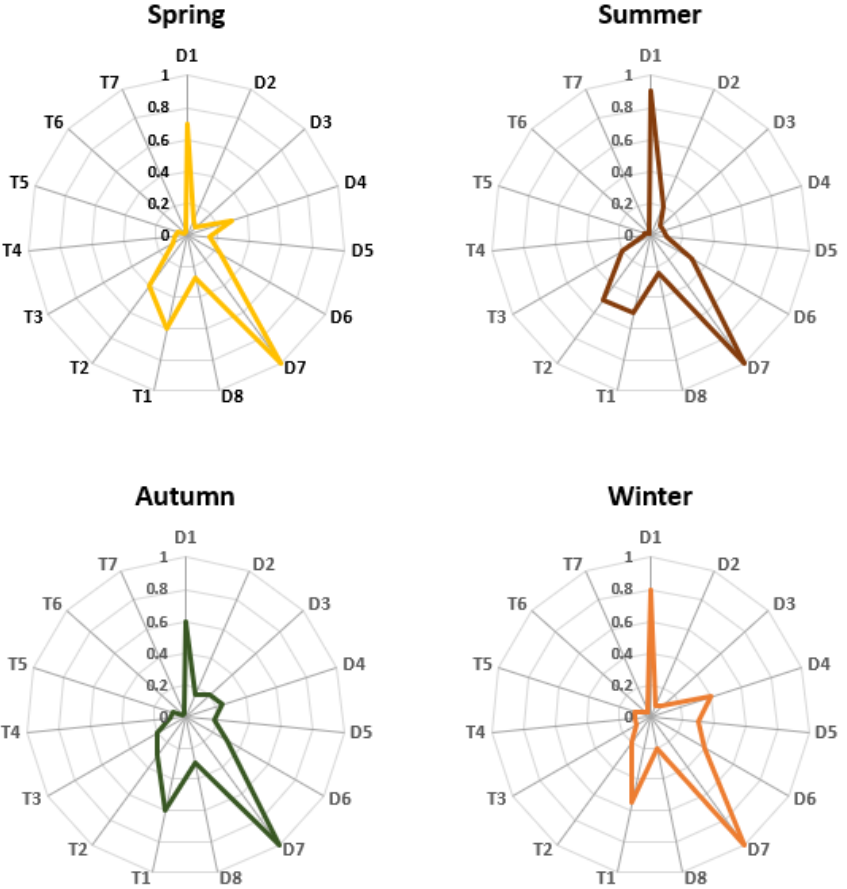
Figure 5. Shapley with different seasonal load characteristics.